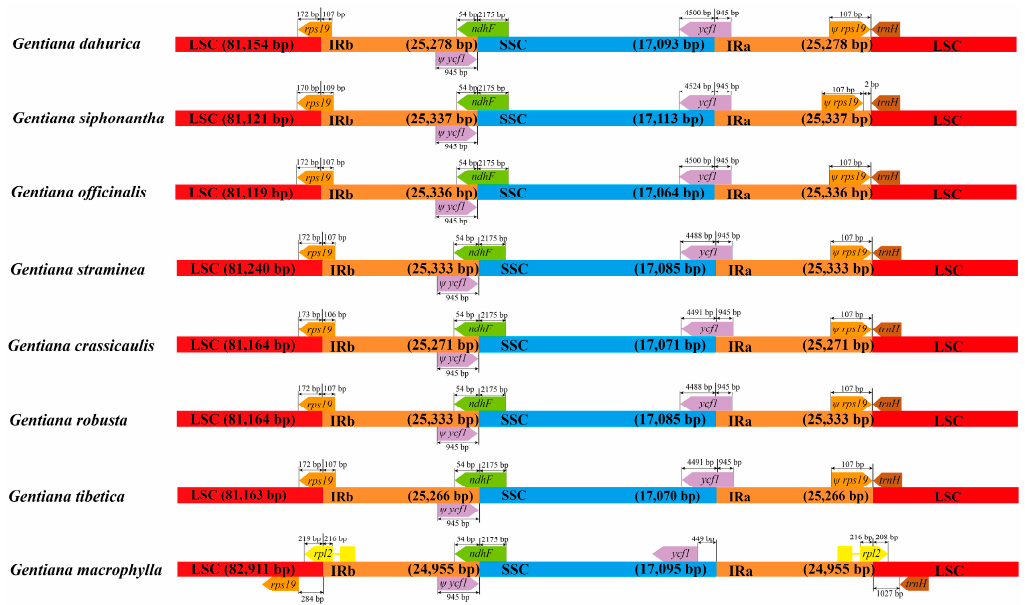
Figure 2. Comparison of chloroplast genome borders of LSC, SSC, and IRs among eight species in Gentiana sect. Cruciata . Ψ indicates a pseudogene.